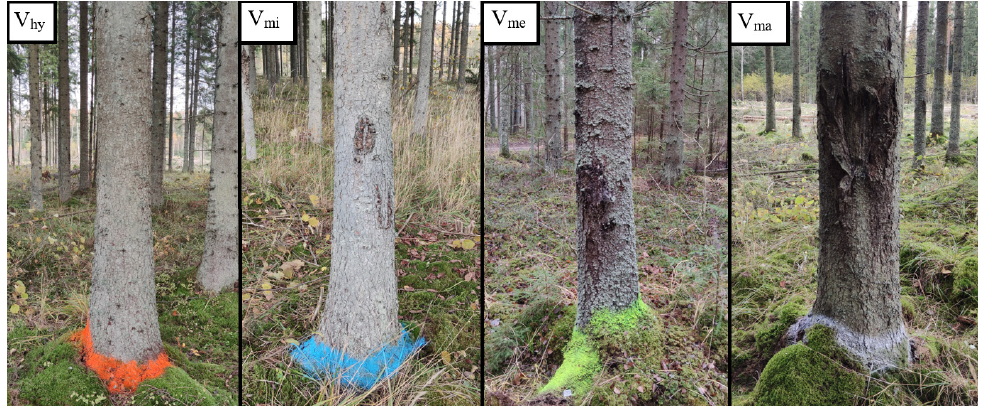
Figure 1. Examples of visual assessment classes (healthy sample tree V hy ; sample tree with minor defect V mi ; sample tree with medium defect V me ; and sample tree with major defect V ma ).